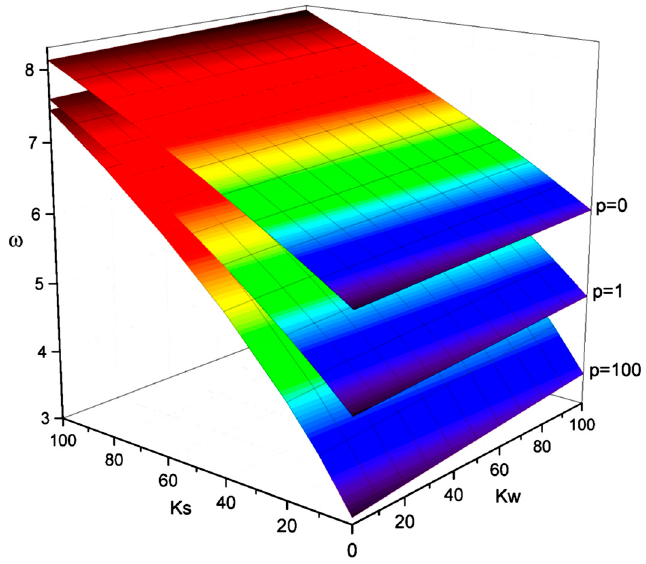
(cid:0) (cid:1) (cid:112) ω a 2 / h ρ / E as a function of foundation ( ) 2 / / a h E ω ω ρ= as a function of founda-